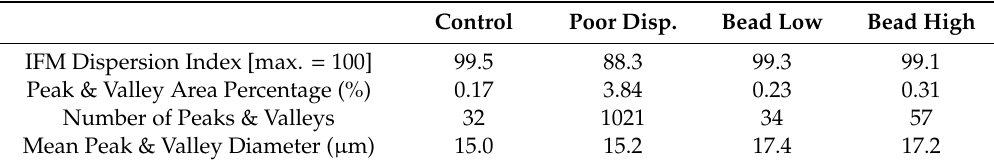
Table 5. Interferometric Microscopy (IFM) Filler Dispersion Results *. Control Poor Disp. Bead Low Bead High IFM Dispersion Index [max. = 100] 99.5 88.3 99.3 99.1 Peak & Valley Area Percentage (%) 0.17 3.84 0.23 0.31 32 1021 34